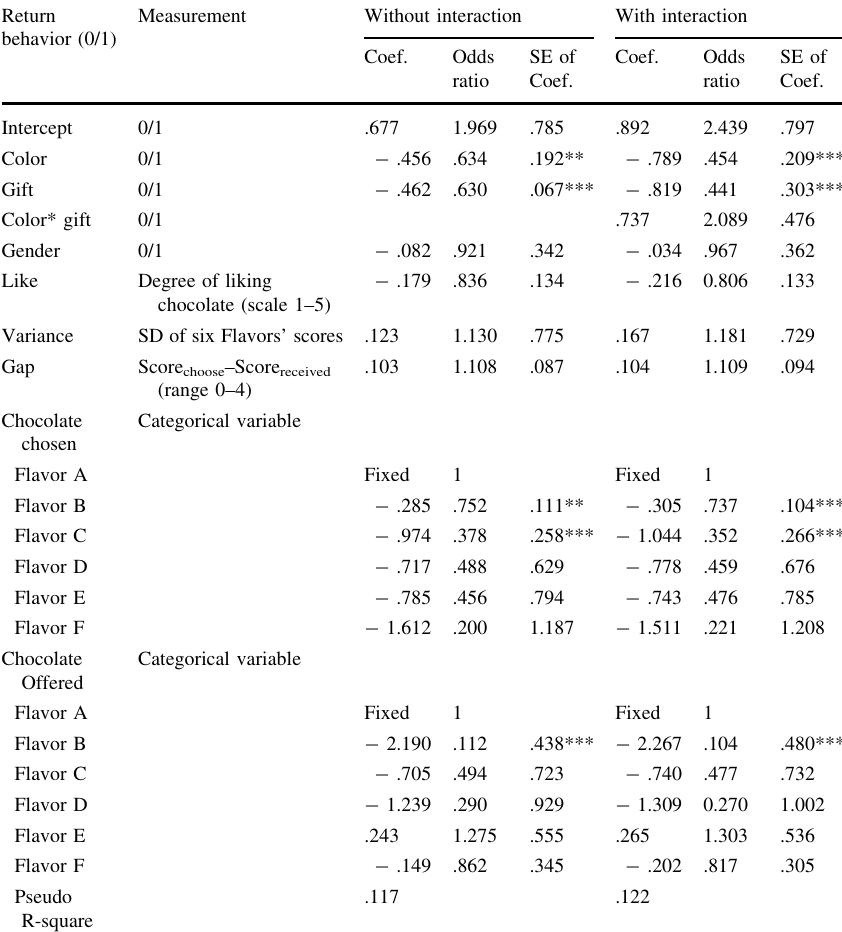
Table 7 Regression results of Study